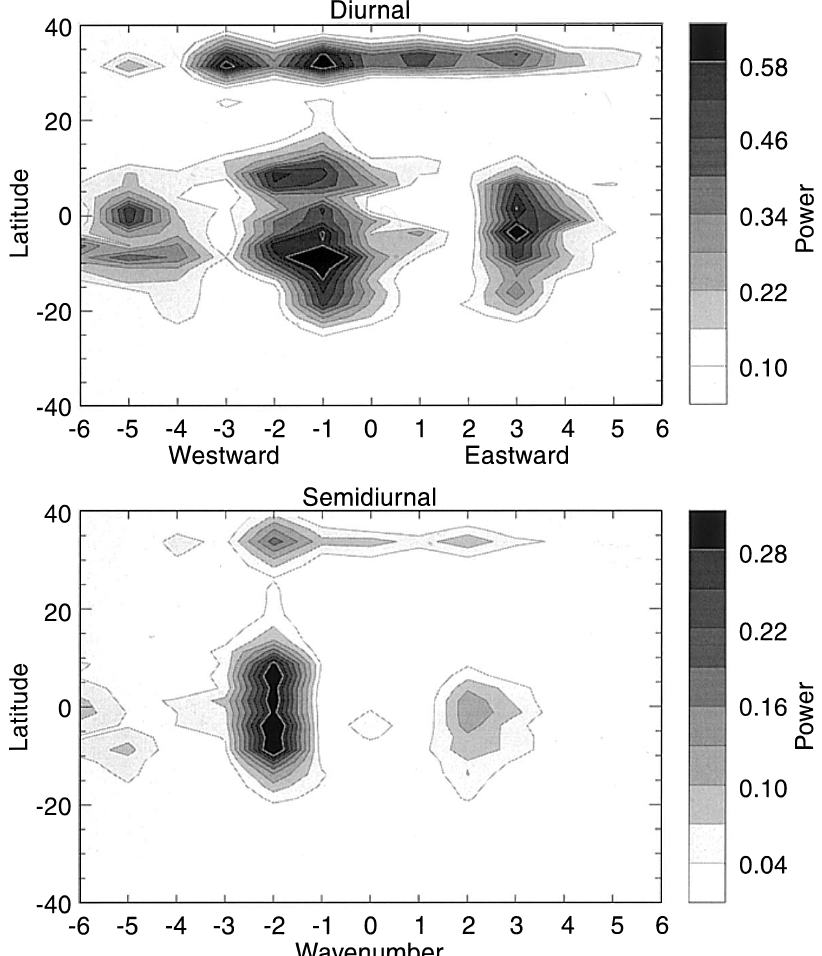
Fig. 2. Latitude and zonal wavenumber distri- butions of power for the diurnal ( top ) and semidiurnal ( bottom ) components of rainfall. Units are arbitrary, and are di(cid:128)erent for the